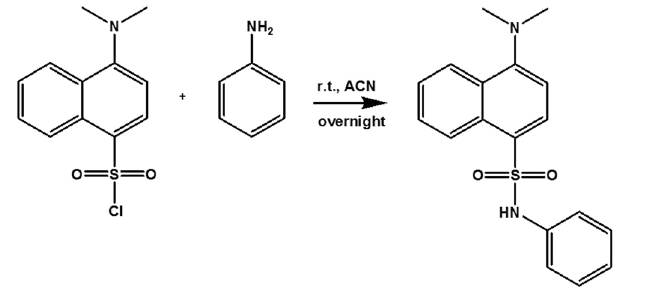
Figure 9. Synthesis of dansyl